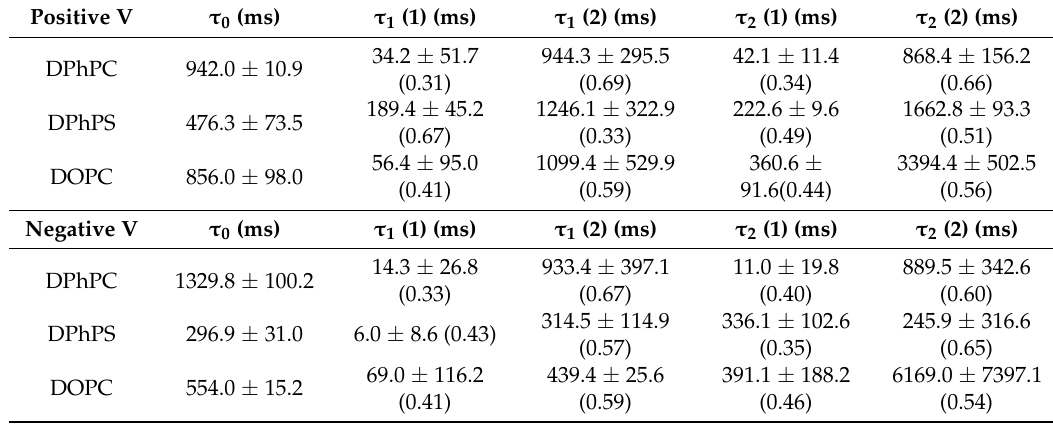
Table 1. Characteristic times obtained from the fitting of histograms in Figure 5 for the time the channel spends before closing the first ( τ 0 ), second ( τ 1 ), and third ( τ 2 ) monomers. τ 0 was fit with a single exponential, while τ 1 and τ 2 were best described by a two-exponential distribution. For τ 1 and τ 2 , the relative weight of the exponentials is indicated in parenthesis, calculated as the relative area defined by each